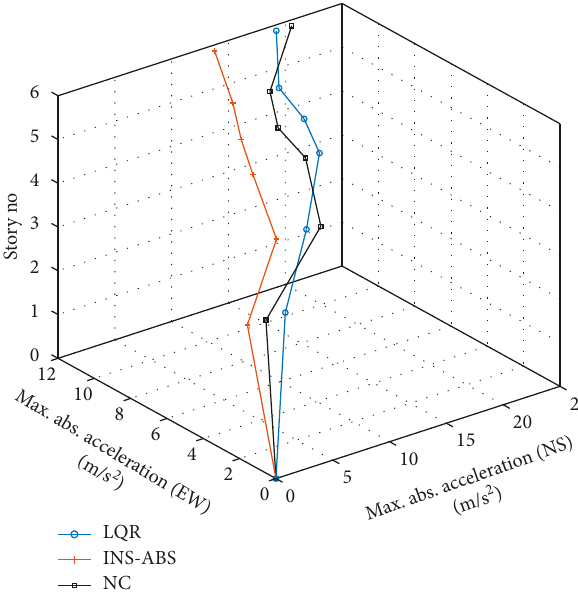
Figure 11: Maximum absolute accelerations in N-S and E-W directions for Erzincan bidirectional ground motion.